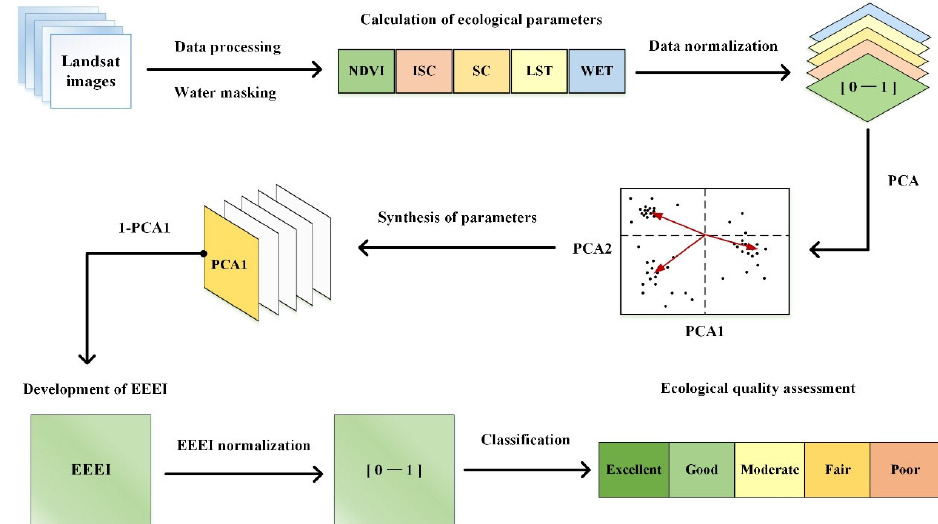
Figure 1. The methodological framework. NDVI: normalized difference vegetation index; ISC: impervious surface coverage; SC: soil coverage; LST: land surface temperature; WET: wetness component of tasseled cap transformation; PCA: principal components analysis; EEEI: enhanced ecological evaluation index.